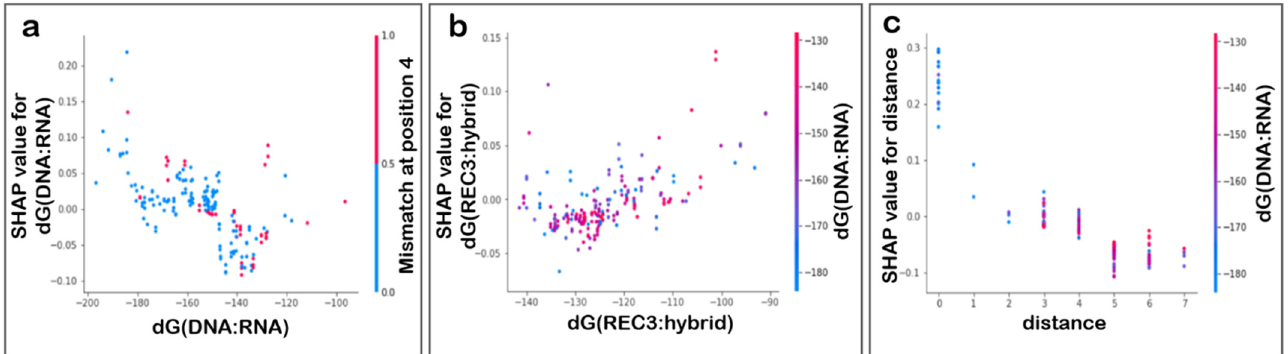
Figure 3. SHAP feature dependence plot. The plots show dependence between ( a ) dG(DNA:RNA) and a mismatch at position 4, ( b ) dG(REC3:hybrid) and dG(DNA:RNA) and ( c ) distance and dG(DNA:RNA). The vertical axis marks the SHAP values for the chosen feature, while the horizontal axis shows spread of the values of the feature. The reference feature was selected by the algorithms automatically and was used to colour the dots that indicate value of the primary feature for an instance. No clear trend can be observed in ( a ) and ( b ). In ( c ), vertical clusters at individual values indicate a correlation with dG(DNA:RNA) values, and the plot also shows a negative correlation of the values of the distance with the output variable.